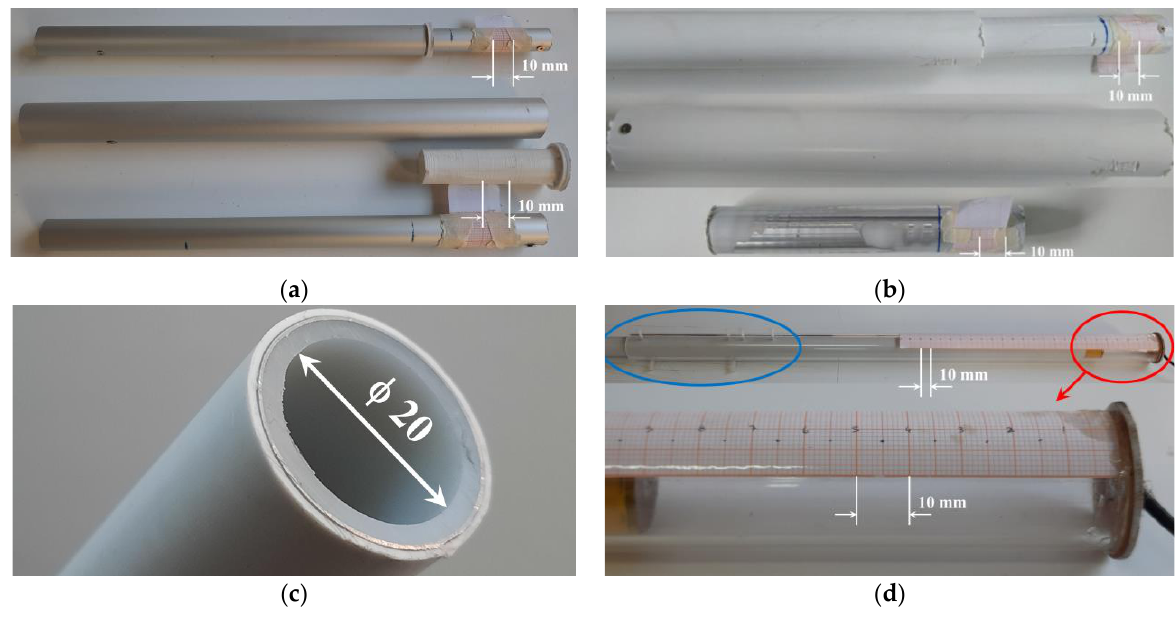
Figure 4. The prototypes of the capacitive transducers: Panel ( a ) the cylindrical capacitive transducer CC1612; Panel ( b ) the cylindrical capacitive transducer CC2620 (the CC2016 transducer is similar, differing only for the tube diameters); Panel ( c ) a detail of the multi-layer polyethylene tube; Panel ( d ) the parallel-plane capacitive transducer PPC20.